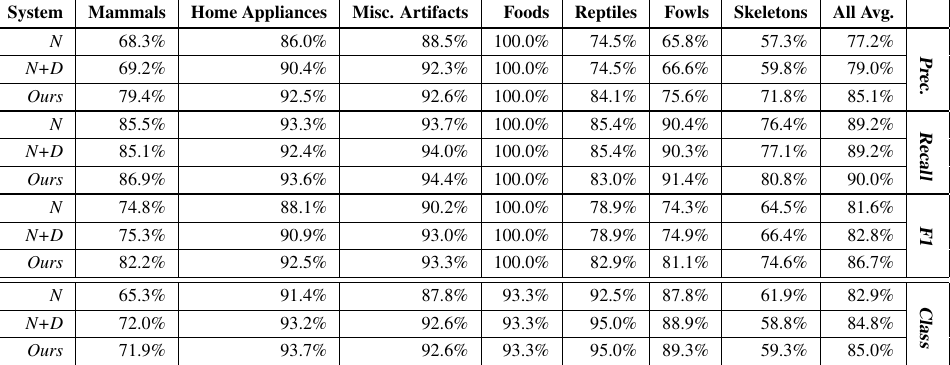
Table 1: Experimental results for segmentation and annotation (top) and classification (bottom).